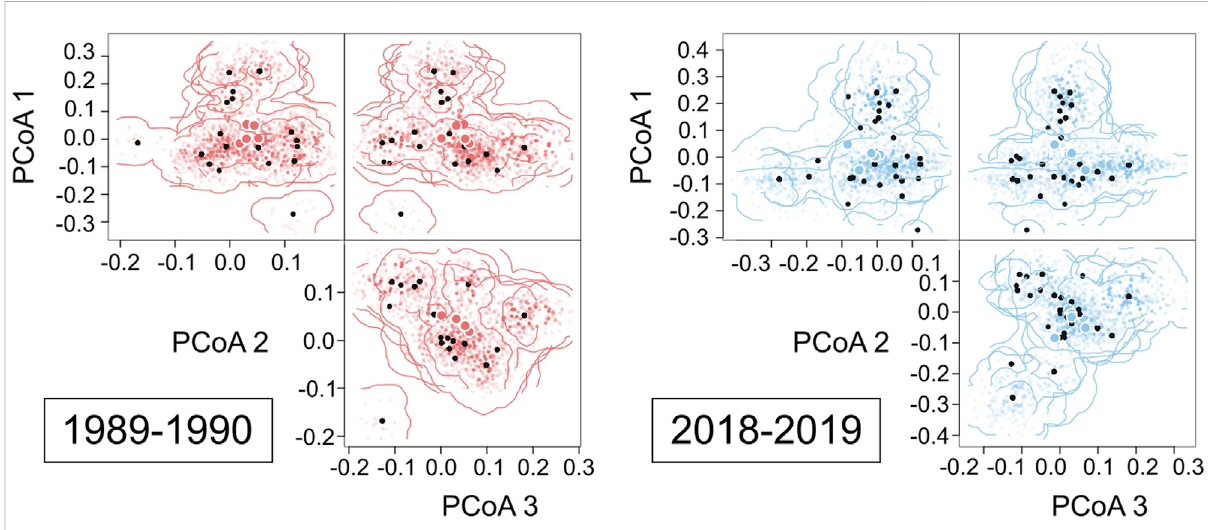
FIGURE 5 A 3-dimensional hypervolume of fi sh assemblages from 1989 – 1990 and 2018 – 2019 surveys. Large circles with white borders represent the centroid of 1989 – 1990 (red) and 2018 – 2019 (blue) hypervolumes (due to the proximity of centroids, some circles are overlapped). The shape and boundaries of each hypervolume are de fi ned by 300 random